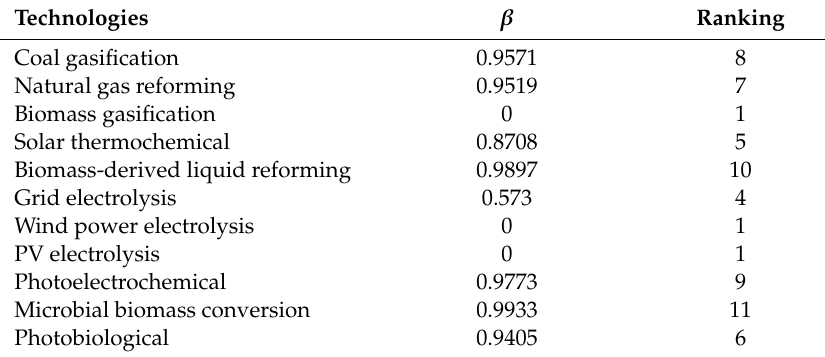
Table 10. E ffi ciency scores of